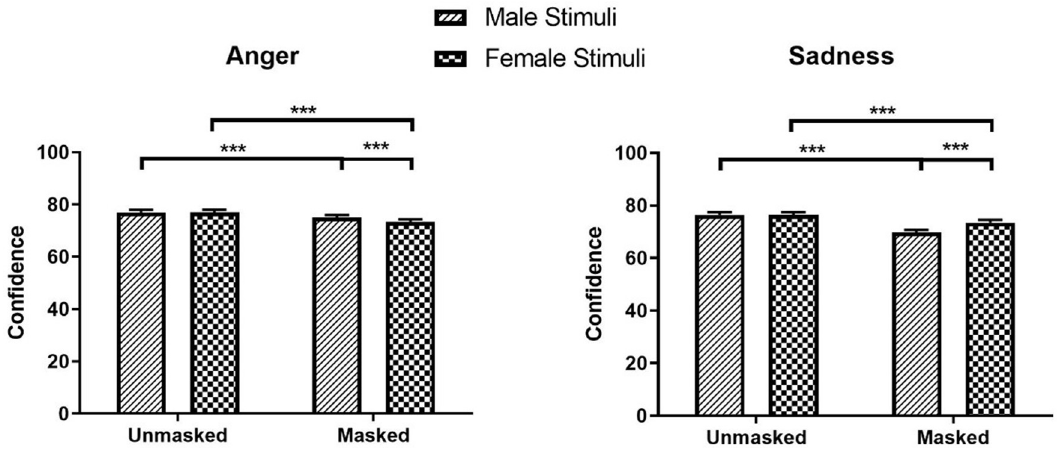
Fig 4. Confidence ratings for anger and sadness as a function of mask and stimuli sex. � p < 0.05, �� p < 0.01, ��� p < 0.001.